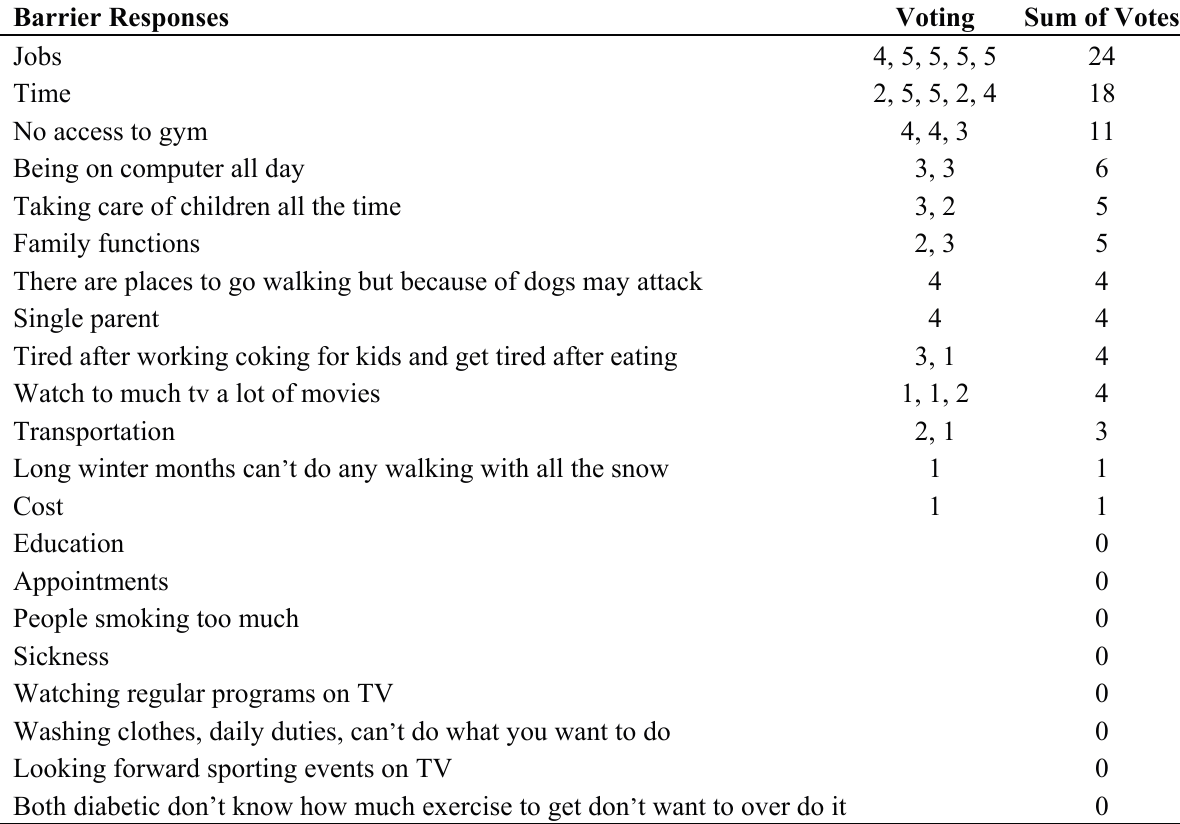
Table 1. Barriers to meeting physical activity recommendations.